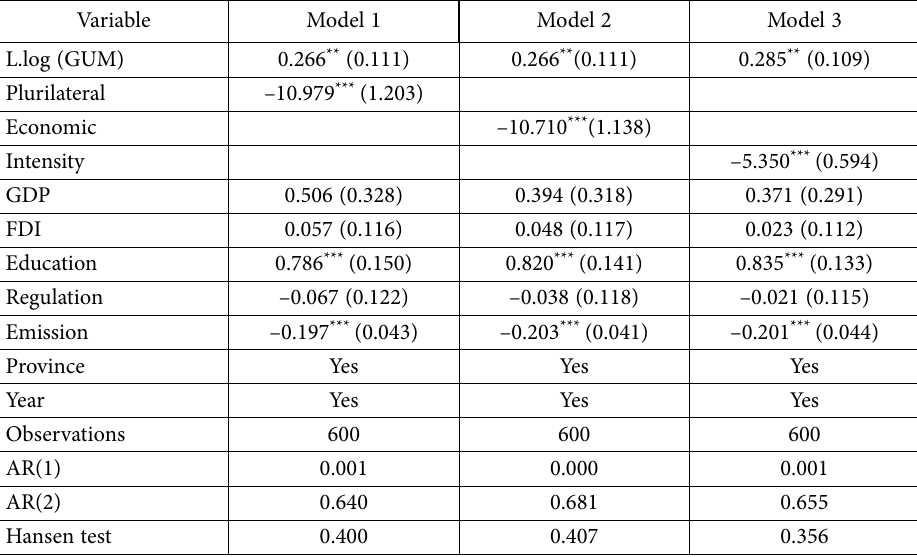
Table 3. Estimation results of the GMM model (Substitution variable: Green utility models)